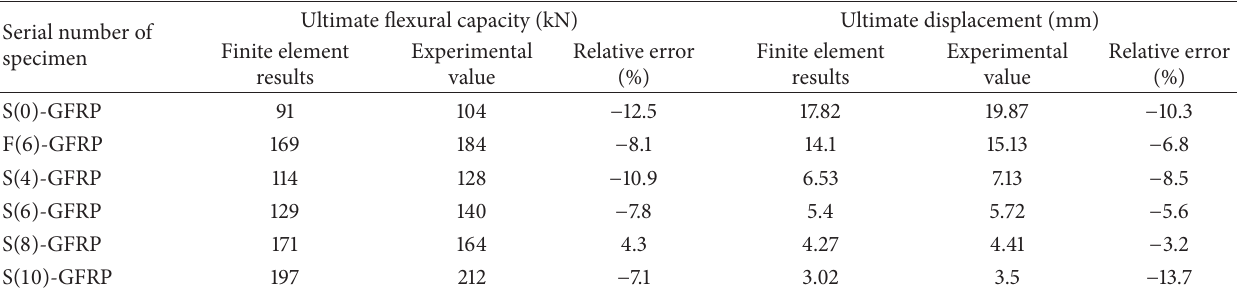
Table 5: Comparisons of flexural capacity between experimental and FEM